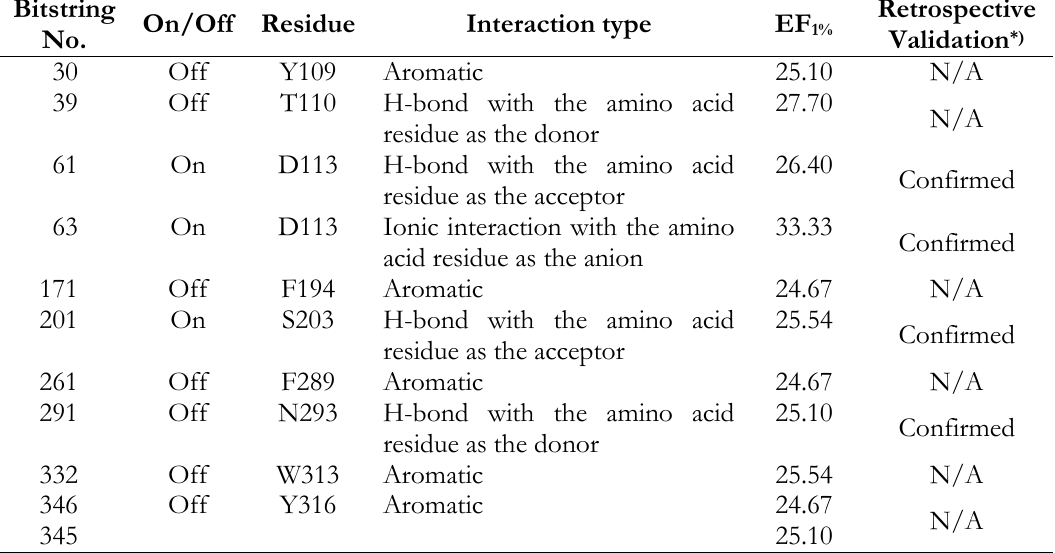
Tabel II . Filtering on PLIF bitstrings for both “on” (represents favorable interaction) and “off” (represents unfavorable interaction) that gave better EF 1% values compared to the unfiltered SBVS campaigns (EF 1% =